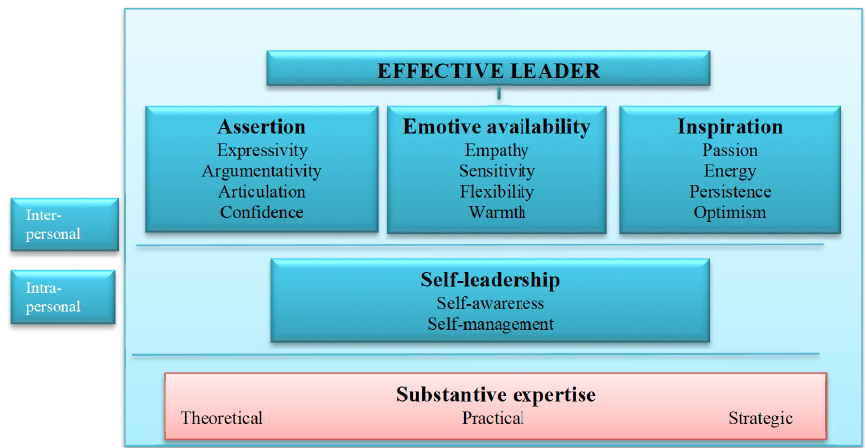
Fig. 1. The foundation of effective